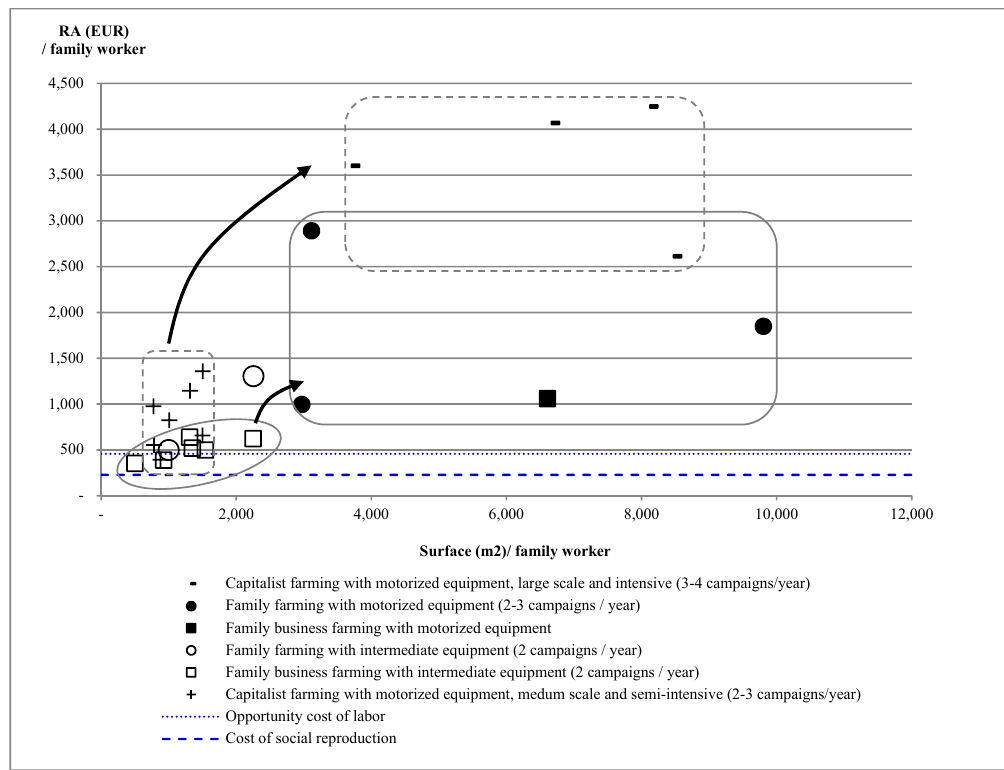
Figure 9. Comparative performance of semi ‐ motorized and motorized production systems.